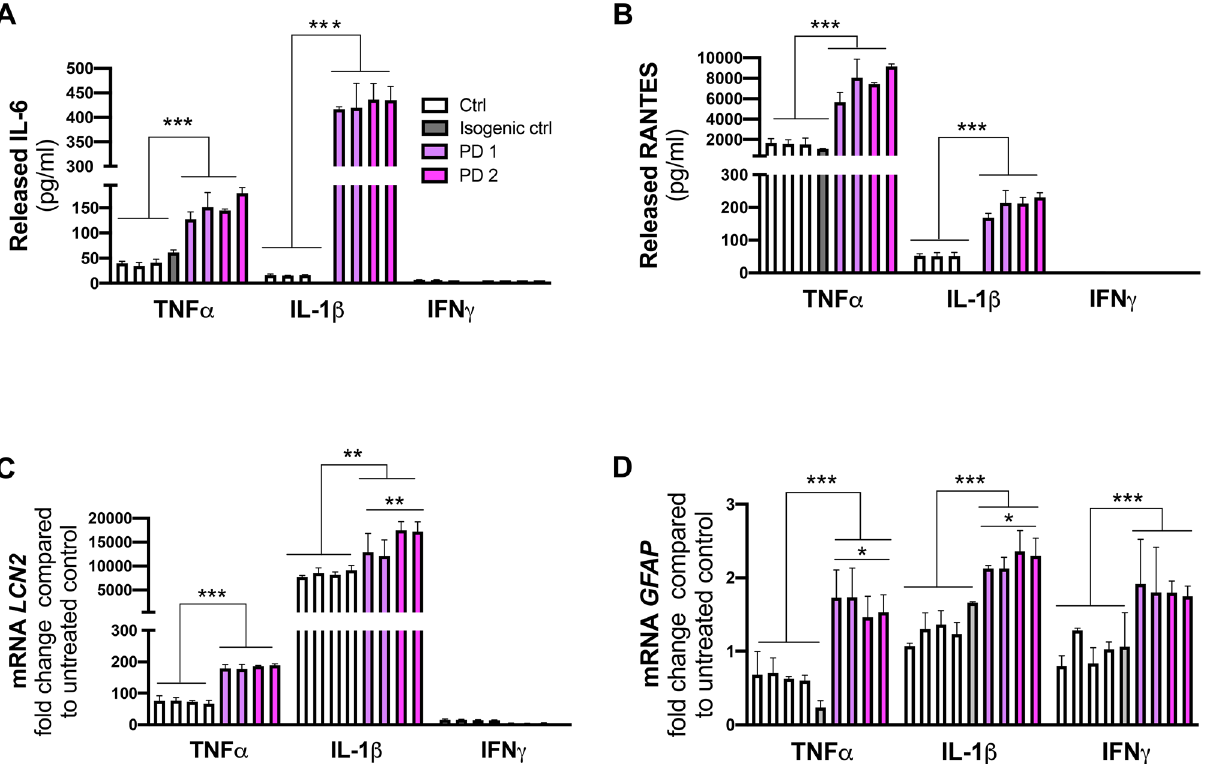
Figure 3. PD astrocytes showed altered phenotype in pro-inflammatory conditions. Release of ( A ) IL-6 and ( B ) RANTES quantified from media after TNFα (50 ng/ml), IL-1β (10 ng/ml) and INFγ (10 ng/ml) stimulation for 24 h measured with CBA assay. Relative gene expression levels of ( C ) LCN2 and ( D ) GFAP in astrocytes treated with TNFα, IL-1β and INFγ shown as fold change from untreated healthy control. Results are presented as mean ± SD from three independent experiments, *p < 0.05, **p < 0.01, ***p < 0.001. The control lines used in the measurements ( A ) and ( B ): Ctrl 1_1, Ctrl 1_2 and Ctrl 2_2.